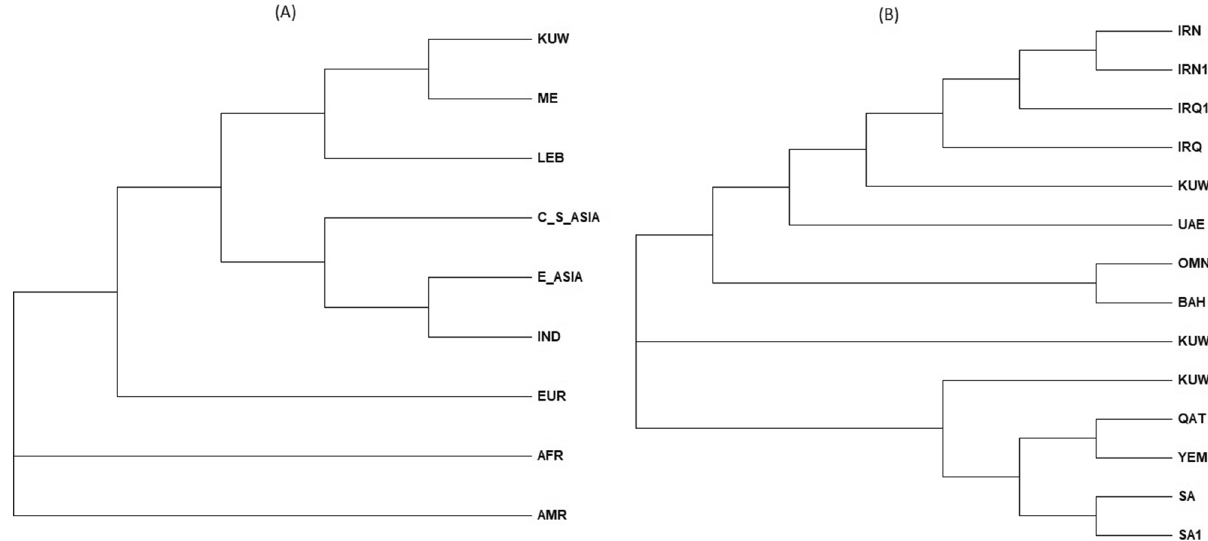
Figure 4. Neighbour-joining tree based on pairwise D A values from allele frequencies of ( A ) the 23 autosomal PowerPlex Fusion 6C loci in Kuwait and populations from Africa (AFR), America (AMR), Central and South Asia (C_S_ASIA), the Middle East (ME), Europe (EUR), East Asia (E_ASIA), Lebanon (LEB) and India (IND; Madhya Pradesh), and (B) the 13 loci shared between the dataset reported here (KUW), previously published Kuwaiti studies (KUW1 and KUW2), and studies of the populations of neighbouring countries Iraq (IRQ and IRQ1), Iran (IRN and IRN1), Saudi Arabia (SA and SA1), United Arab Emirates (UAE), Oman (OMN), Yemen (YEM), and Bahrain (BAH). The nodes represent a common ancestor and the branching tips are descendants of that common ancestry (generated using Mega X software version 10.0.5 37